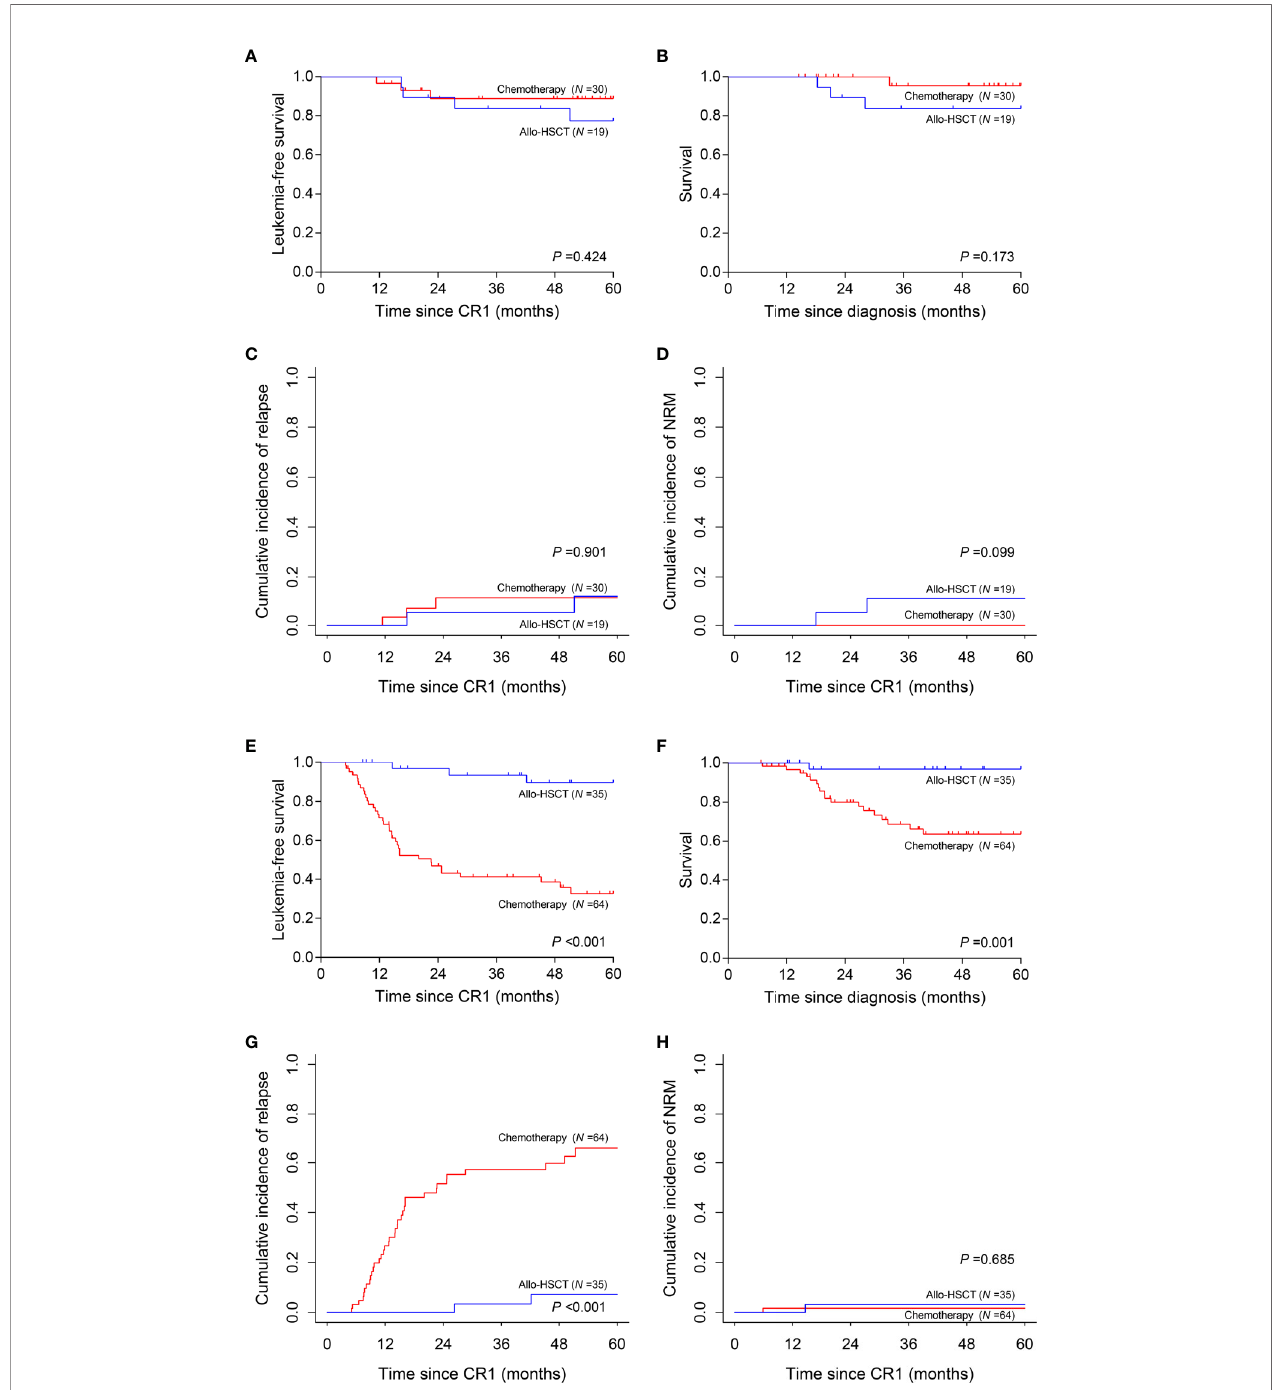
FIGURE 5 | Prognosis of two post-remission therapies by risk strati fi cation. (A – D) Leukemia-free survival, survival, cumulative incidence of relapse and non- relapse mortality analyses in low-risk subgroup. (E – H) Leukemia-free survival, survival, cumulative incidence of relapse and non-relapse mortality analyses in high-risk